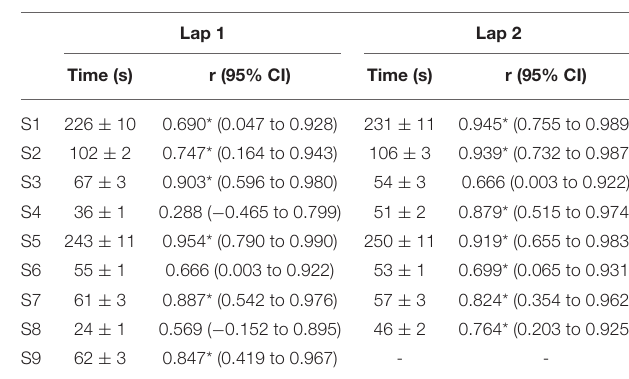
TABLE 1 | Mean ± standard deviation section times and Pearson correlation coefficients (r) between section times and total race time, with the associated 95% confidence interval (CI), for the women ( n =